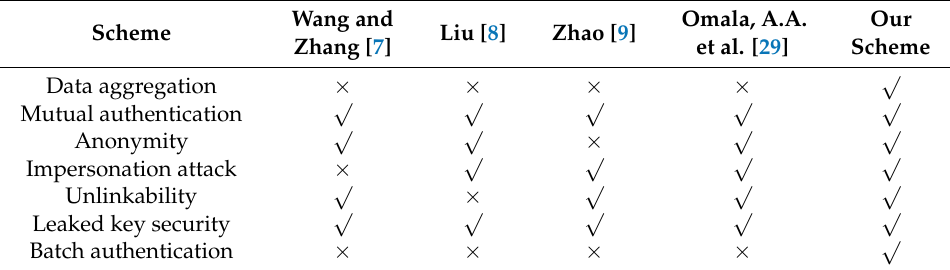
Table 2. Security comparison